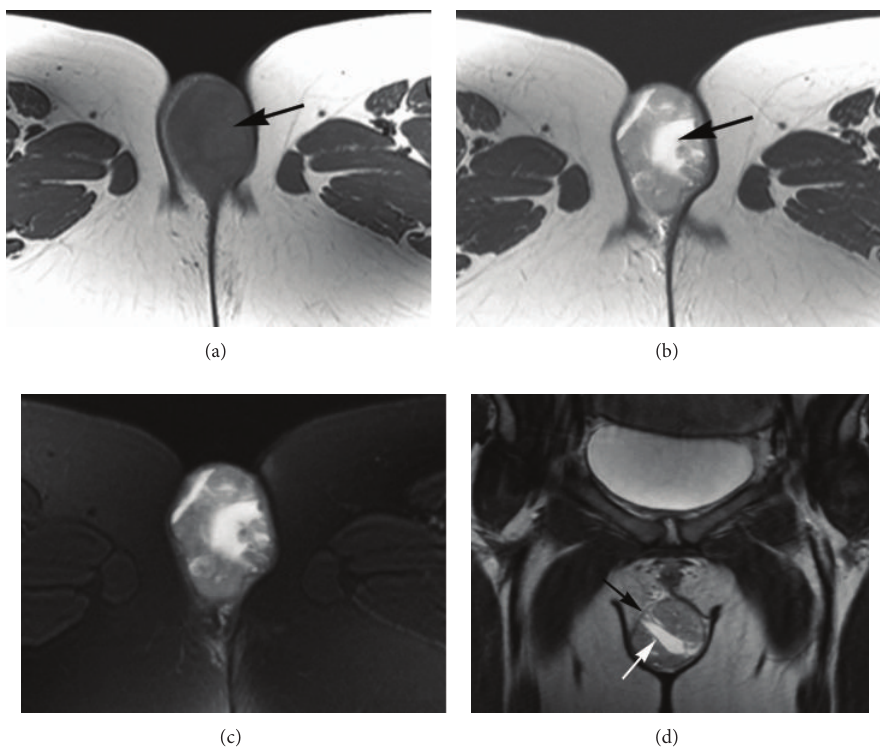
Figure 1: Magnetic resonance images of the pelvis. (a) Axial T1-weighted spin-echo image (TR = 700 ms/TE = 10ms). A well-defined, ovoid mass in the subcutaneous tissue of the inferior right labia majora is seen (arrow), with smooth contours and no evidence of infiltration of adjacent structures. The mass has homogenous signal which is isointense to skeletal muscle. (b) Axial T2-weighted fast spin-echo image (TR = 4450ms/TE = 89 ms). The mass has heterogeneous high signal intensity, with areas of very high signal intensity suggesting the presence of fluid (arrow) (c) Axial T2-weighted fast spin-echo image with frequency selective fat saturation (TR = 5266 ms/TE = 89ms). No inflammatory changes are seen in the adjacent fat. (d) Coronal T2-weighted fast spin-echo image (TR = 5216 ms/TE = 83ms). A well-defined thin capsule around the mass (black arrow) and thin internal septa (white arrow) are